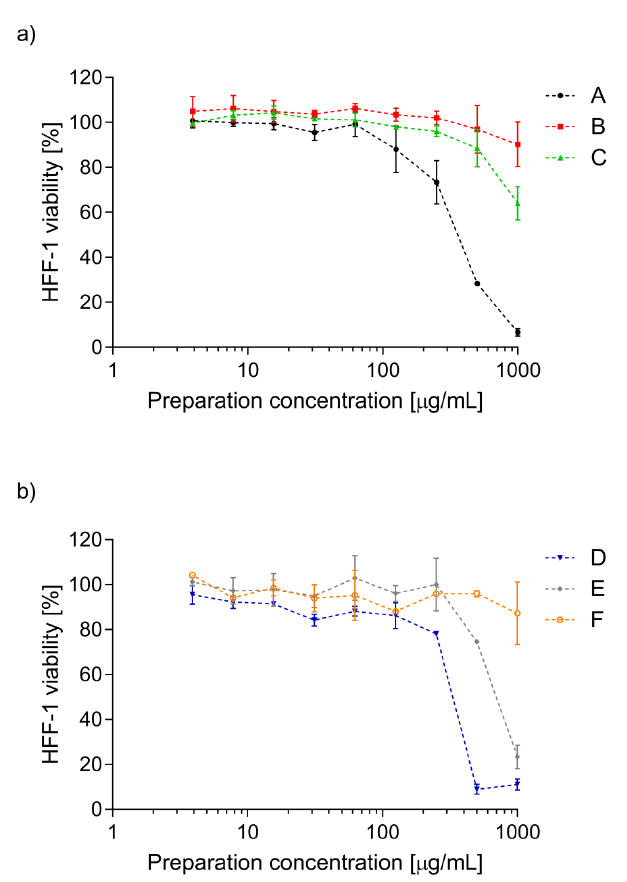
Figure 3. The viability of human foreskin fibroblasts line HFF-1 exposed (24 h) on the preparations (A–F) of E. rhamnoides (L.) A Nelson leaves ( a ) and twigs ( b ) (3.9–1000 µ g/mL). Data represent (A–F) of E. rhamnoides (L.) A Nelson leaves ( a ) and twigs ( b ) (3.9–1000 µg/mL). Data represent means ± SD of two independent experiments in means  SD of two independent experiments in duplicates.